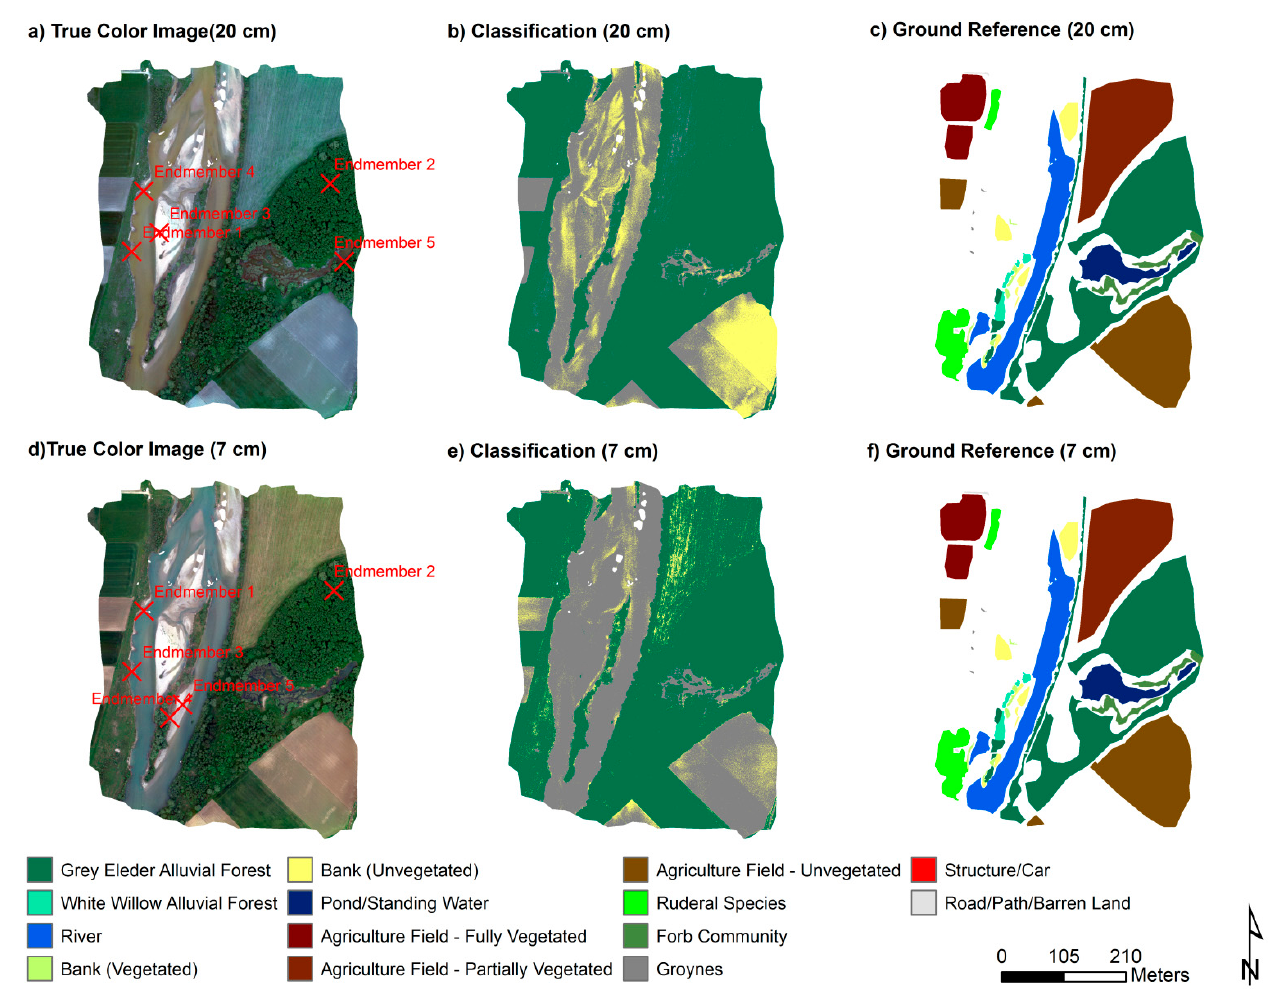
Figure 10. ( a ) Narrow-band image from 17 May 2016 of the River Drau study area with extreme/erroneous pixels masked out at the 20 cm pixel size. The map also shows locations of the identified purest pixels extracted as endmembers and used in the classification; b ) Land cover classification generated using the 20 cm narrow-band image, endmembers extracted from ( a ), and the Spectral Angle Mapper algorithm within ENVI; c ) Reference data used in assessing the accuracy of the classified image in ( b ); ( d ) Narrow-band image from 17 May 2016 of the River Drau study area with extreme/erroneous pixels masked out at the 7 cm pixel size. The map also shows locations of identified purest pixels extracted as endmembers and used in the classification; ( e ) Land cover classification generated using the 7 cm narrow-band image, endmembers extracted from ( d ), and the Spectral Angle Mapper algorithm; ( f ) Reference data used in assessing the accuracy of the classified image in ( e